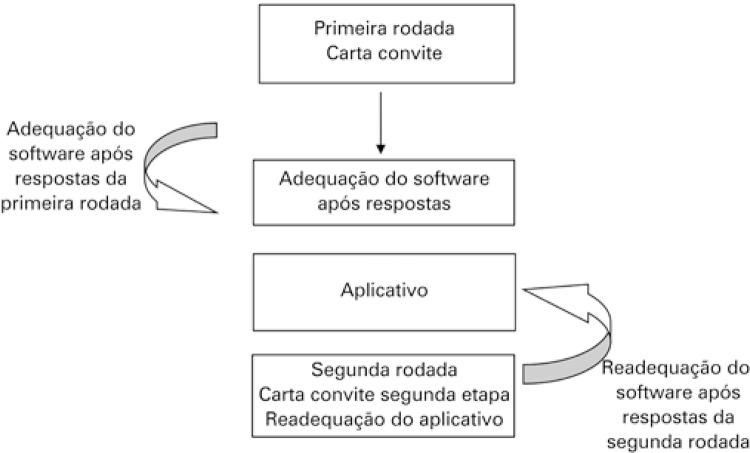
Etapas da técnica Delphi para avaliação do software Individually Designed Optimum Dosing Strategies